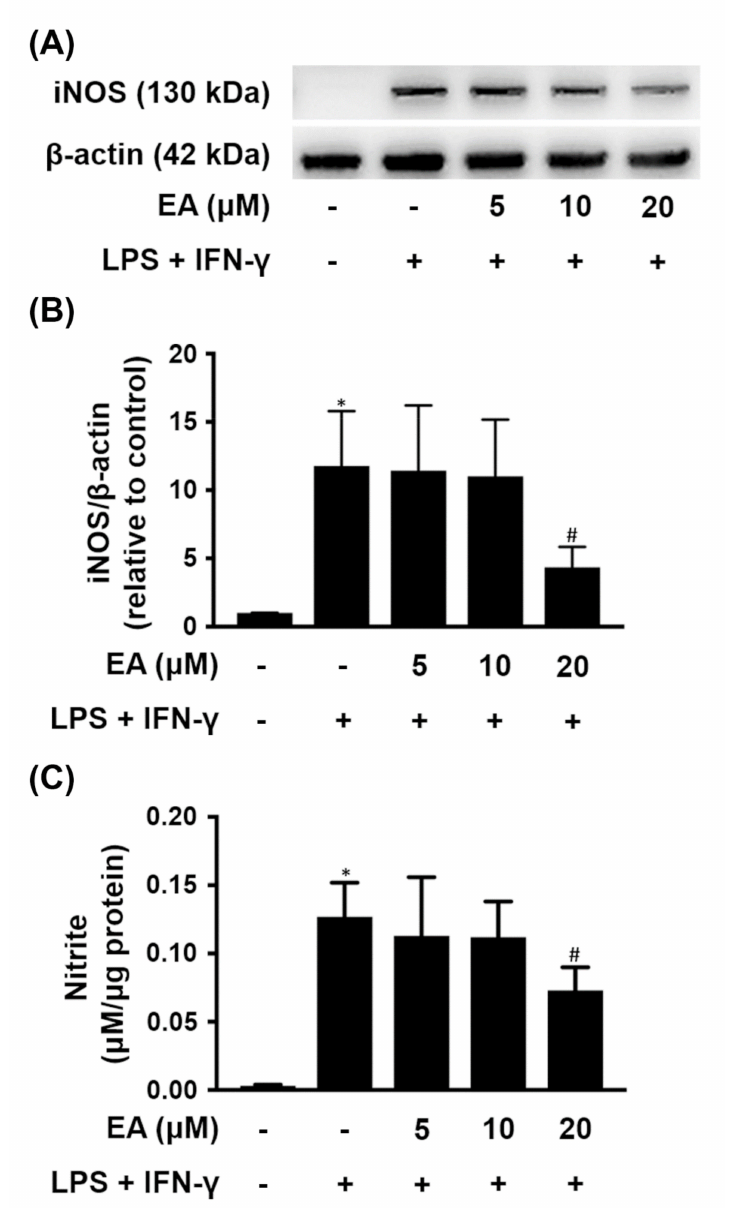
Figure 2. Effect of EA on iNOS expression and NO production in BV-2 cells treated with LPS and IFN- γ . BV-2 cells were treated with the indicated concentration of EA for 15 min and then stimulated with LPS (500 ng/mL) and IFN- γ (50 ng/mL) for 24 h. ( A ) The protein levels of iNOS were detected by western blot ( n = 3). β -actin was used as a loading control. ( B ) Quantitative densitometry was used to calculate the ratio of iNOS to β -actin, which was normalized to the control. The relative density was estimated by NIH ImageJ densitometric analysis. ( C ) Estimated NO release derived from the nitrite present in the culture medium using the Griess reagent assay ( n = 3). The results are expressed as the mean ± SD. * p < 0.05 compared to the untreated group. # p < 0.05 compared to the LPS/IFN- γ